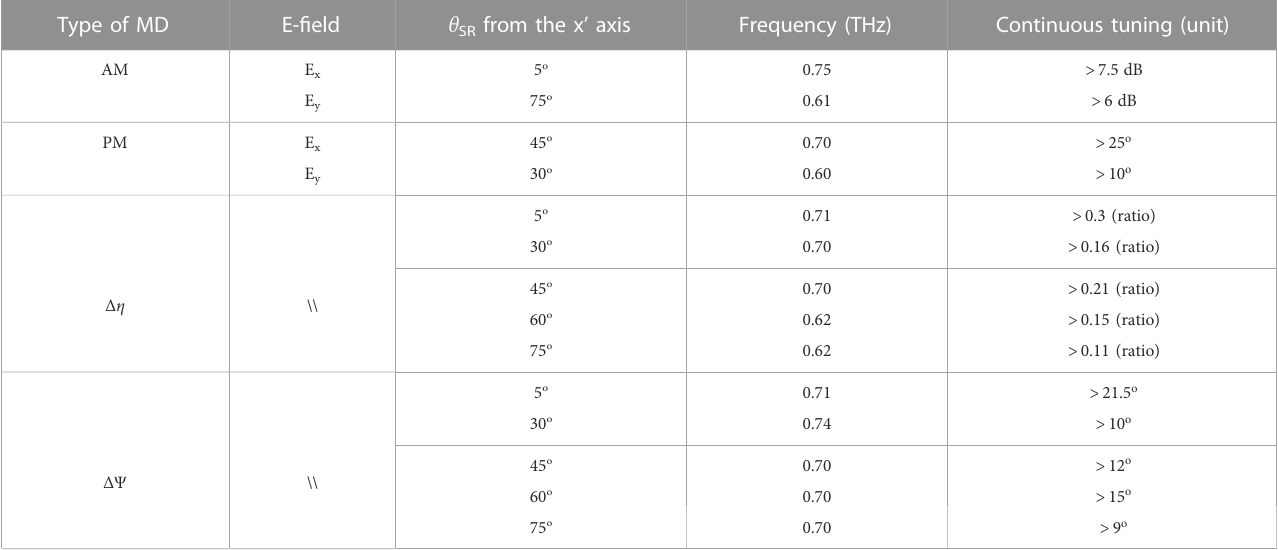
TABLE 2 Maximum MDs when computing all the temporal